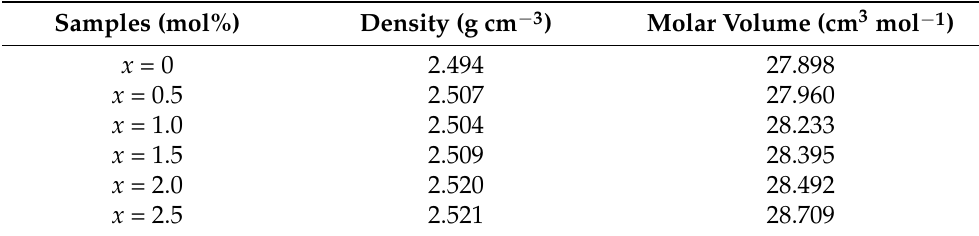
Table 1. Values of density ( ρ ) and molar volume ( V a ) for (59.5– x ) B 2 O 3 –20Na 2 O–20CaO– x V 2 O 5 – Er 2 O 3 –0.5AgCl ( x = 0, 0.5, 1.0, 1.5, 2.0 and 2.5 mol%). Samples (mol%)